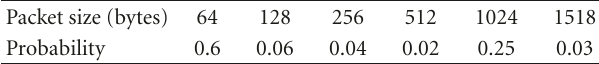
Table 2: Distribution of packet size for the ethernet tra ffi c